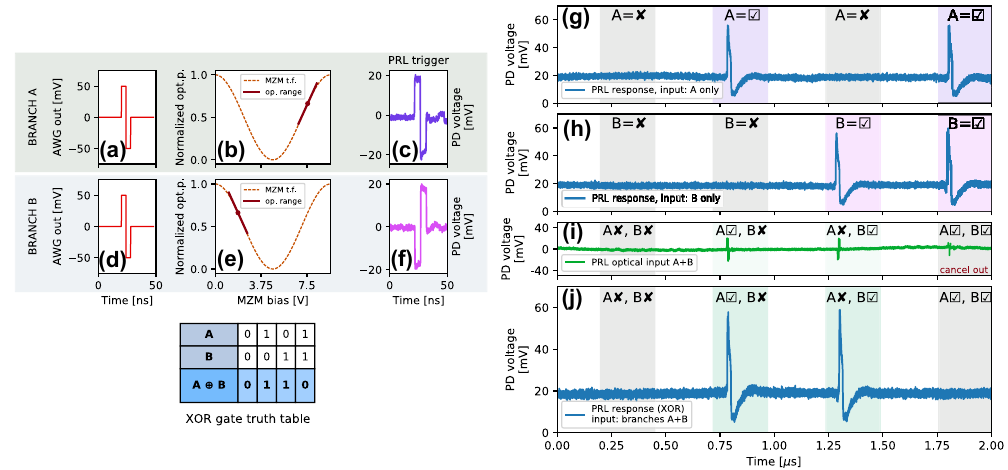
Figure 4: Two-input exclusive OR (XOR) task in the PRL: (a, d) a bipolar RF trigger pulse is processed through a layer of two, (b, e) MZMs with different operation points of their transfer function, providing mutually inverted input perturbations, (c, f) on two optical input branches (denoted as A, B) to the PRL. The input pulses can individually elicit spiking responses from the PRL node (g, h), but when arriving simultaneously, they cancel out (i) and no spike is fired (j). This demonstrates the XOR task operation. The truth table for the task is included for